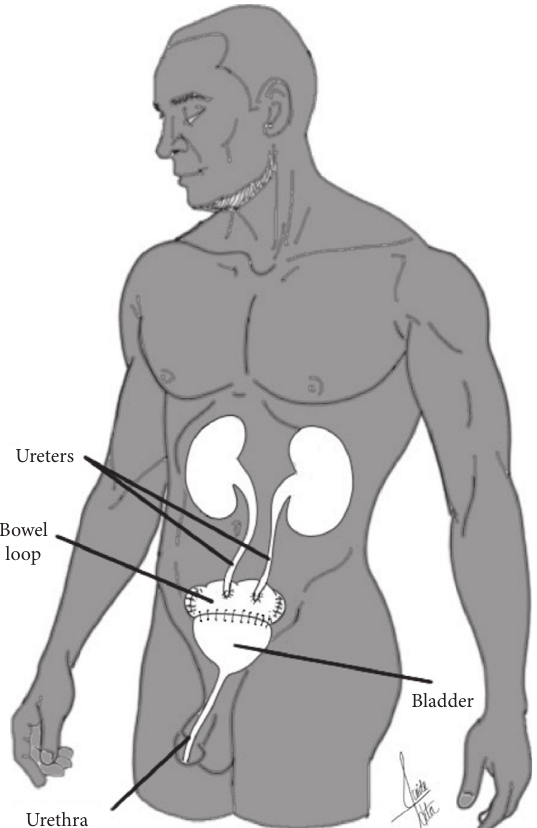
Figure 3: Orthotopic bladder substitution. A section of the bowel is used to reconstruct the bladder, allowing the use of the native urethral